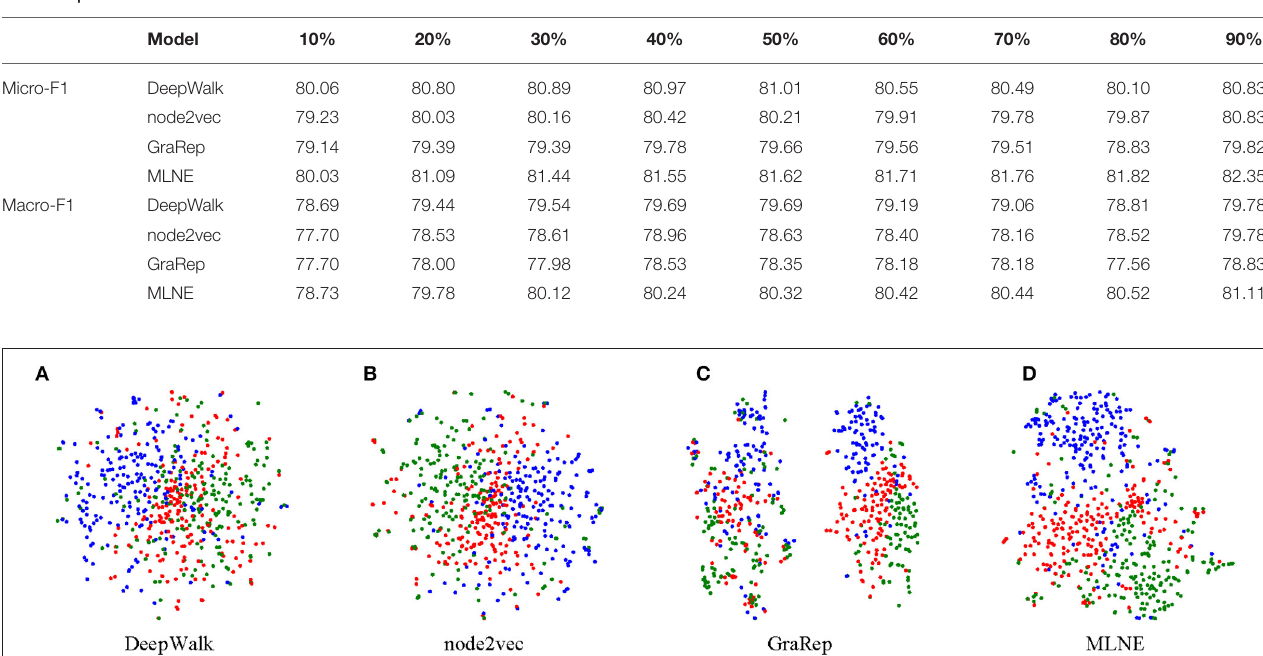
TABLE 6 | Node classification results on Pubmed.